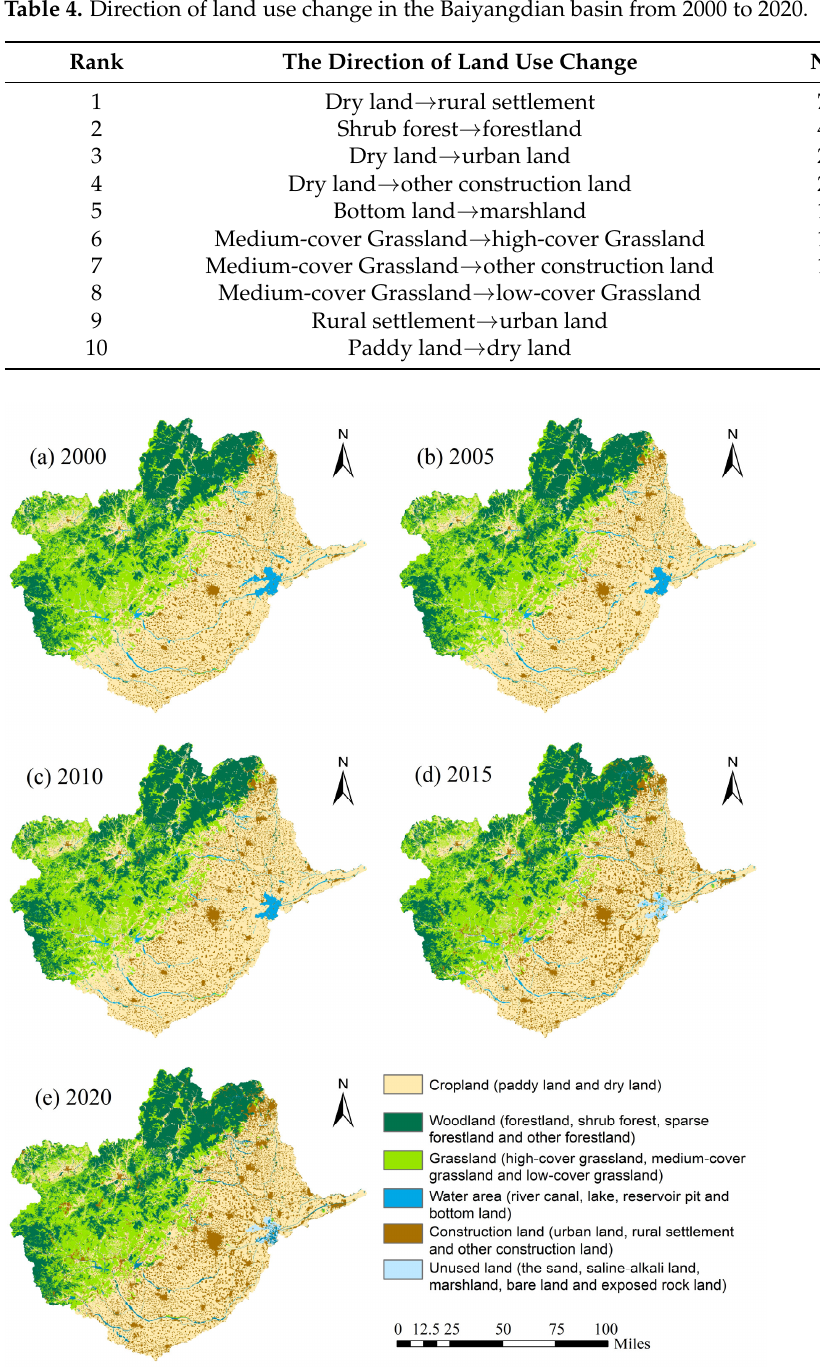
Figure 2. Spatial and temporal distribution of land use types in the Baiyangdian basin from 2000 to 2020. Table 4. Direction of land use change in the Baiyangdian basin from 2000 to 2020.